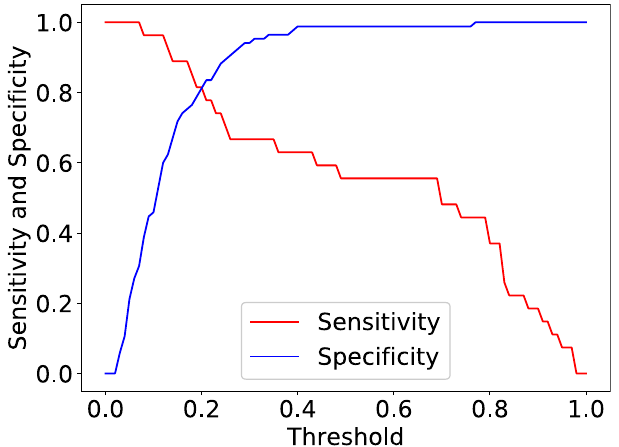
Figure 5. Sensitivity and Specificity Curves of the Proposed CNN Pipeline with respect to the chosen threshold.